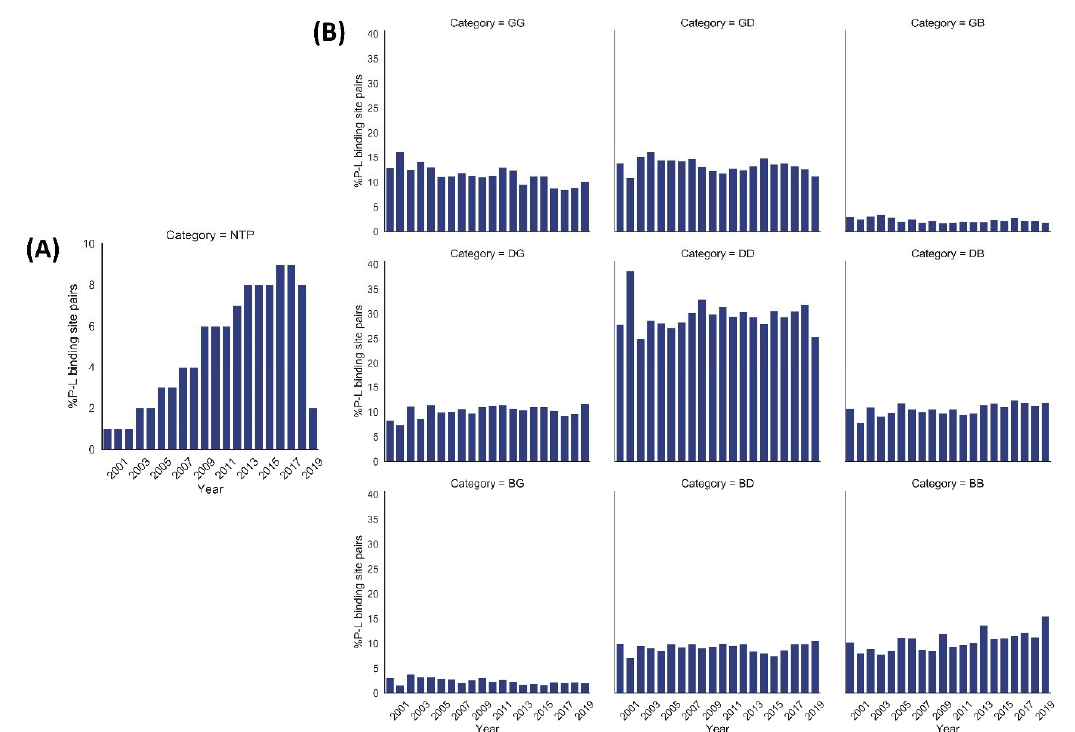
Figure 2. Year ‐ wise percentage distribution of protein–ligand (P–L) binding site pairs in our dataset from 2000 to 2019 (till July). ( A ) Year ‐ wise percentage distribution of normalized total number of pairs (NTP) of protein–ligand binding sites. The NTP values were calculated using the equation mentioned in Section 4.6. The number of protein–ligand binding site pairs shows a steady increase over the years. ( B ) Year ‐ wise distribution of %P–L binding site pairs of each quality category based on VHELIBS assessment. The quality trend of each of the nine categories (GG, GD, GB, DG, DD, DB, BG, BD, BB) of P–L binding site pairs is almost similar over approximately the last two decades.